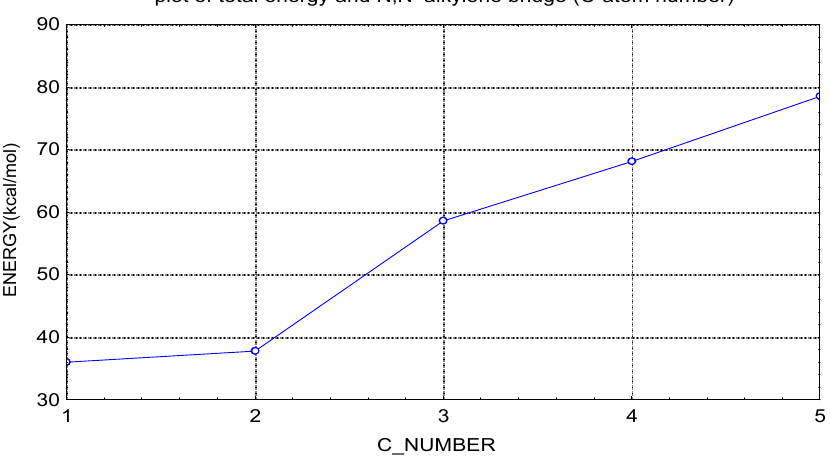
Figure 2. The relationship of torsional angle and N, N’-alkylidene bridge in DBPAs. The total energy of the DBPA molecules also varies with the N, N’-alkylidene bridge length. The total energies measured are 36.0, 37.8, 58.6, 68.1 and 78.5 kcal/mol, respectively, corresponding to N, N’-alkylidene bridge C-atom numbers of 1, 2, 3, 4, and 5. The plot of these parameters vs C-atom number is shown in Figure 3.